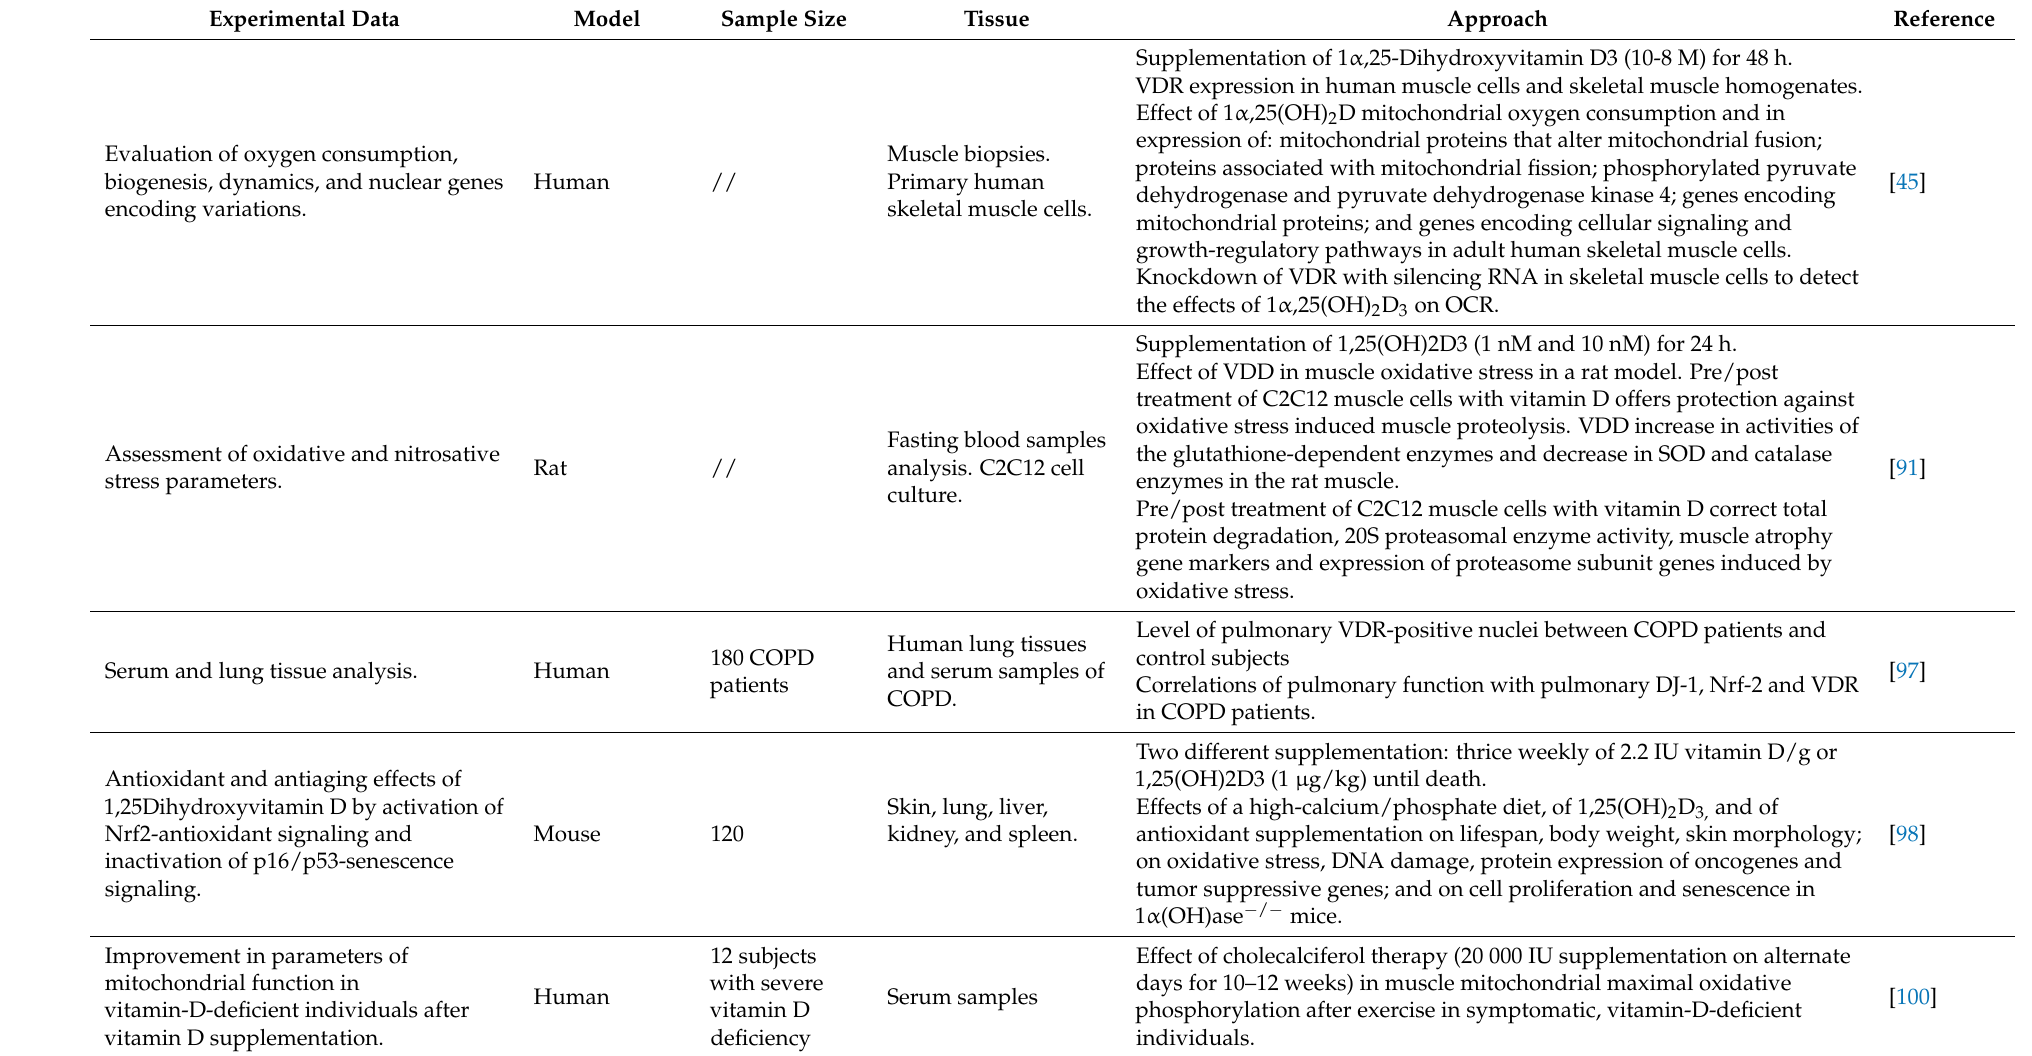
Table 1. Possible vitamin D linked mechanisms involved in mitochondrial